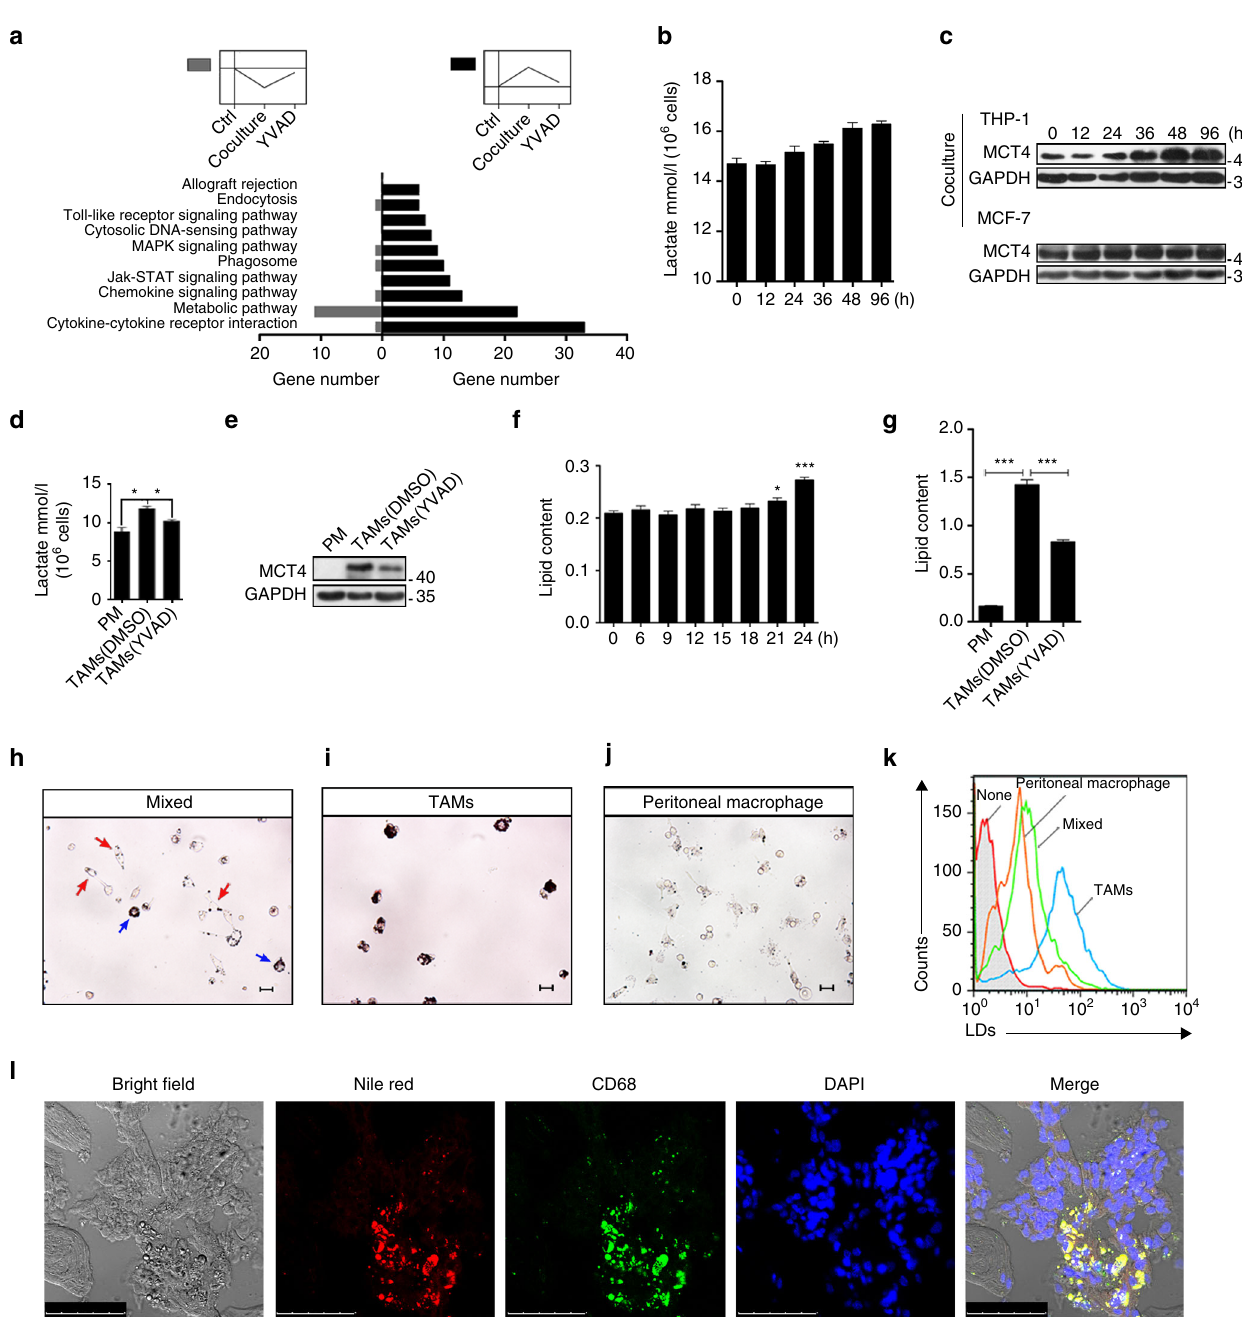
Fig. 4 PPAR γ cleavage causes a metabolic reprogramming in TAMs. a Pathway analysis was conducted on these 618 pre-selected genes. b Lactate secretion ability was measured ( n = 3). c Protein level of MCT4 was analyzed by immunoblot, THP-1 (upper), MCF-7 (lower). d , e Peritoneal macrophages and TAMs were isolated from tumor-bearing MMTV-PyMT mice, MCT4 expression was analyzed by immunoblot ( e ). Or lactate concentration in the supernatant was quanti fi ed one day later ( d ; n = 8). f After cocultured for indicated time, THP-1 macrophages were stained by oil red, then analyzed lipid content by a quantitative method ( n = 3). g Lipid content in peritoneal macrophages and TAMs from tumor bearing MMTV-PyMT mice was quanti fi ed ( n = 8). h Single-cell suspensions from tumors were prepared and allowed to attach for 6 h, lipid content was shown by Oil Red O staining, tumor cells were marked by red arrows, lipid overloaded cells were marked by blue arrows. Scale bars, 10 μ m. i , j Staining of TAMs ( i ) peritoneal macrophages ( j ) from MMTV-PyMT tumor-bearing mice with oil red. Scale bars, 10 μ m. k Flow cytometry analysis of lipid levels in TAMs, tumor tissue whole population cells and peritoneal macrophage from MMTV-PyMT tumor-bearing mice with Nile Red staining. l The CD68-labeled TAMs and Nile Red-labeled lipid droplets were observed in frozen sections (from six patients). Scale bars, 75 μ m. All statistic data in this fi gure represent means ± s.e.m., (* P < 0.05, ** P < 0.01, *** P < 0.001, ns, not signi fi cant, one way ANOVA for multiple